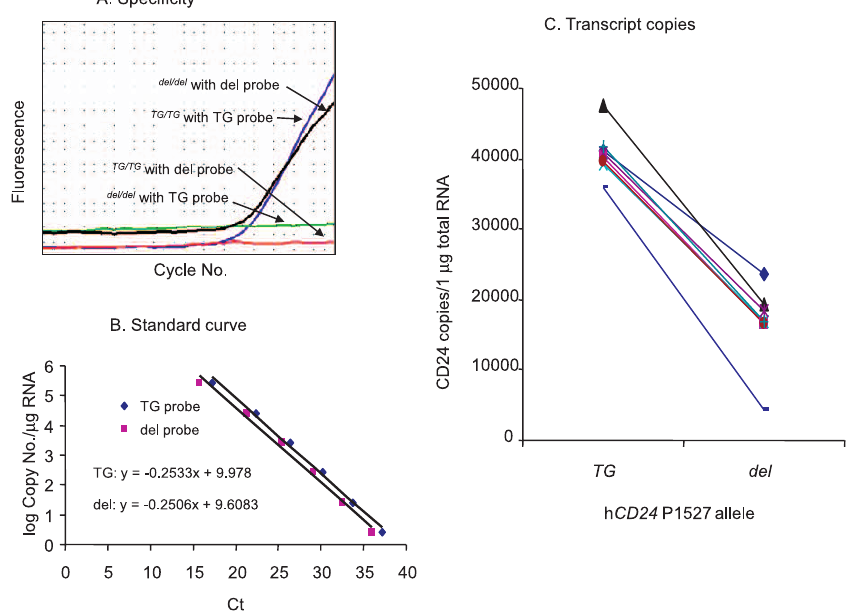
Figure 4. Allele-Specific Transcripts in P1527 TG/del Heterozygous Individuals Total RNA was isolated from the blood of eight OSU MS patients with the P1527 TG/del heterozygous genotype. The allele mRNA expression of CD24 was analyzed using TaqMan RT-PCR. (A) Specificity of the primers. DNA from patients homozygous for either TG or del at the P1527 was amplified with allele-specific primers. Note that no products were detected when the primers and the patient genotypes were mismatched. (B) Standard curve of the allele-specific amplification. The known copies of plasmid cDNA were used as templates. (C) Quantification of allele-specific CD24 transcripts. Total RNA from eight P1527 TG/del patients was amplified with allele-specific primers. The copy numbers were calculated based on the standard curves. A significant difference in the mRNA expression of CD24 was observed between the P1527 del and P1527 TG alleles ( p , 0.0001). Data shown have been repeated twice.